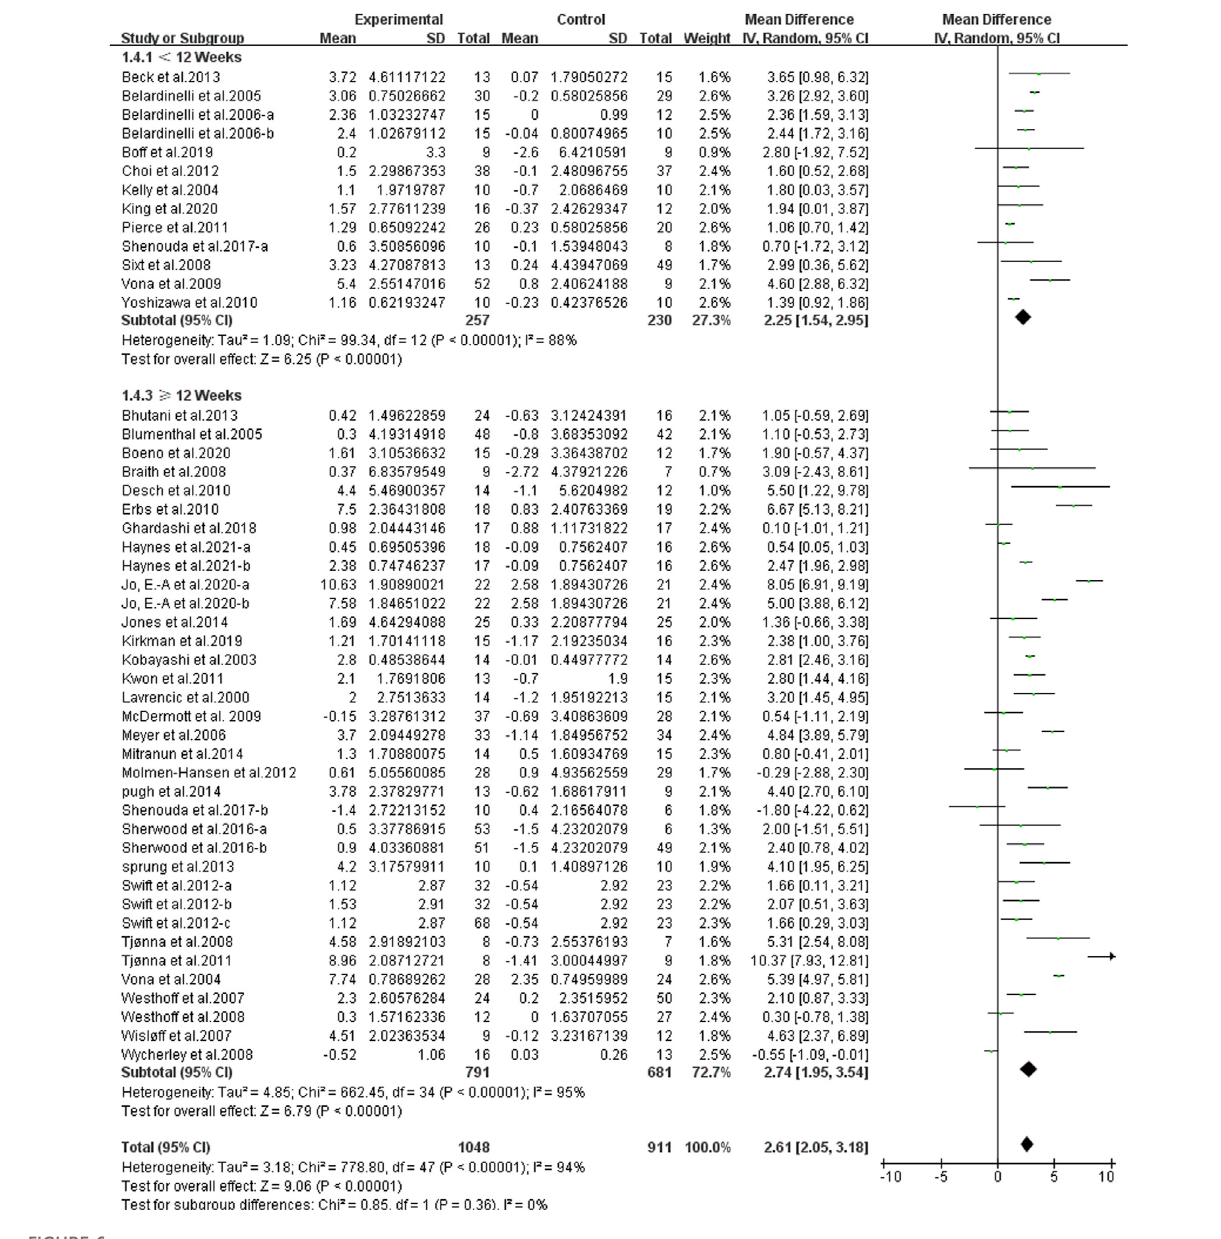
FIGURE 6 Meta-analysis results of the effect of different durations of continuous aerobicexercise on FMD. The pooled estimates were obtained from random effects analysis. Diamonds indicated the size of the effect of each study summarized as WMD. The size of the shaded square was proportional to the percentage weight of each study. Horizontal lines represented the 95% CI and the vertical dashed line represented the overall